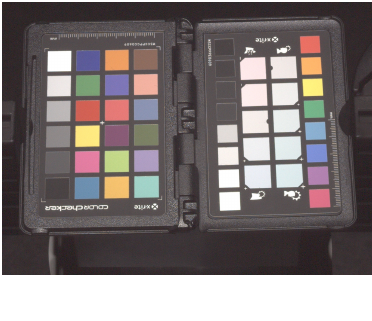
The X-Rite ColorChecker Passport. The color chart is used to calibrate the cameras’ color profiles in the Dome 1 and Dome 2 as well as the cameras’ response functions of the Dome